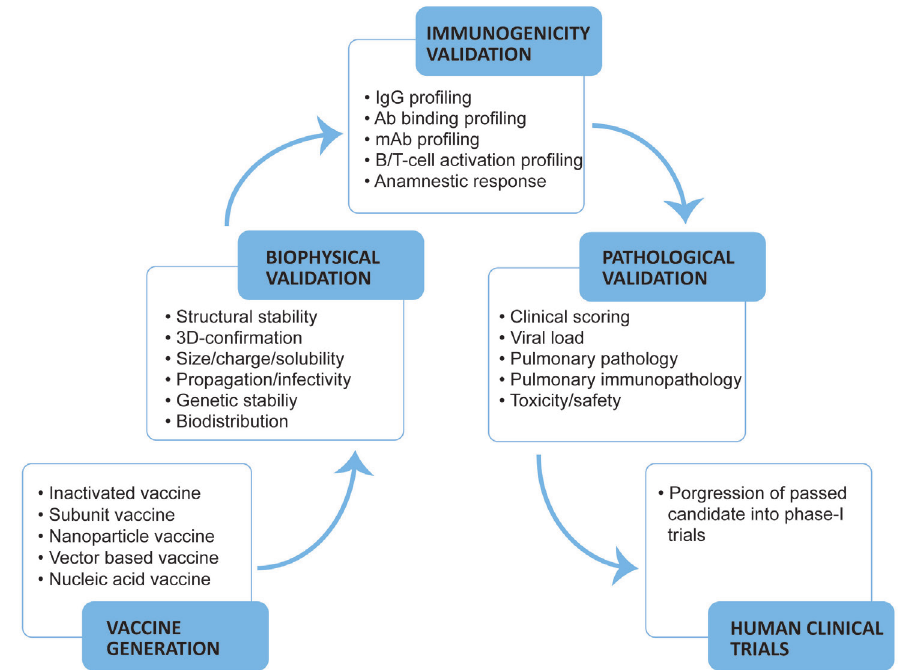
Figure 2. Flowchart of COVID-19 vaccine validation